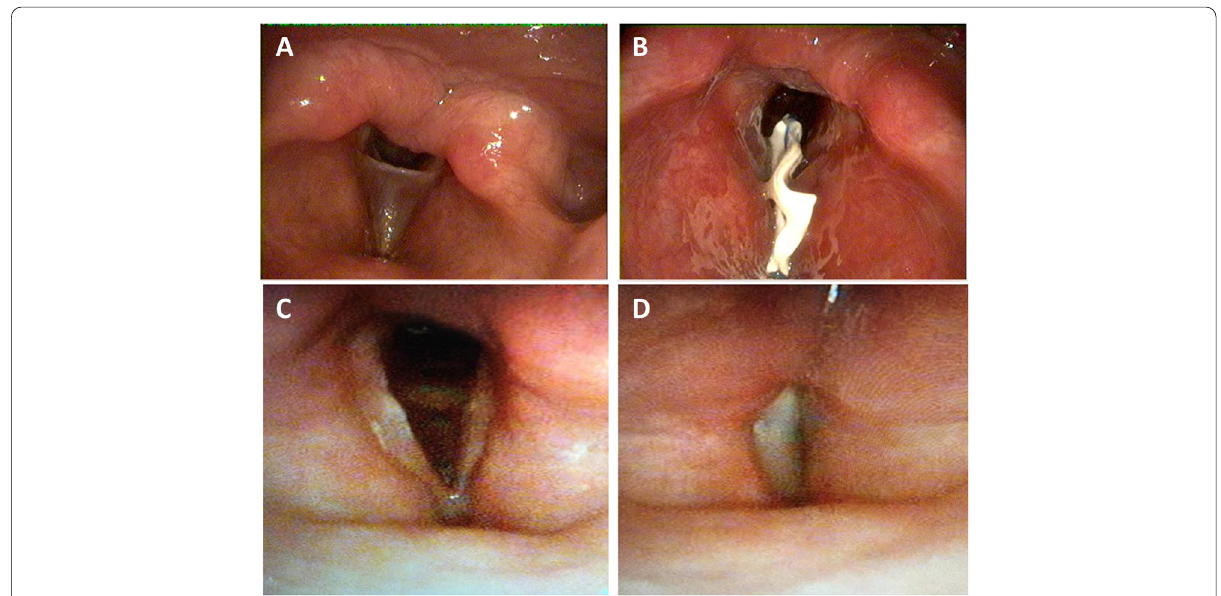
Fig. 2 This figure shows subject with congenital laryngeal web type IV (80%) ( A ). The ePTFE keel was fixed after excision of the web and the